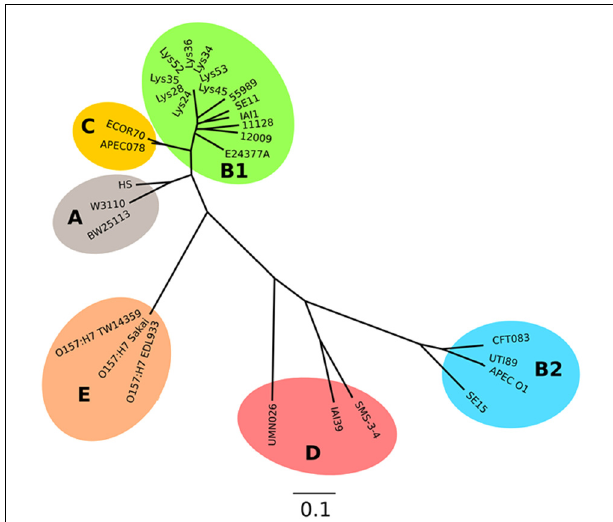
FIGURE 5 | Parsimony tree of whole-genome SNPs shows relatedness of the curli-negative strains with other known E. coli strains. Phylogeny generated with kSNP3 using sequence data indicated in Supplementary Table S2. Non-curli producing strains form a distinct cluster within the B1